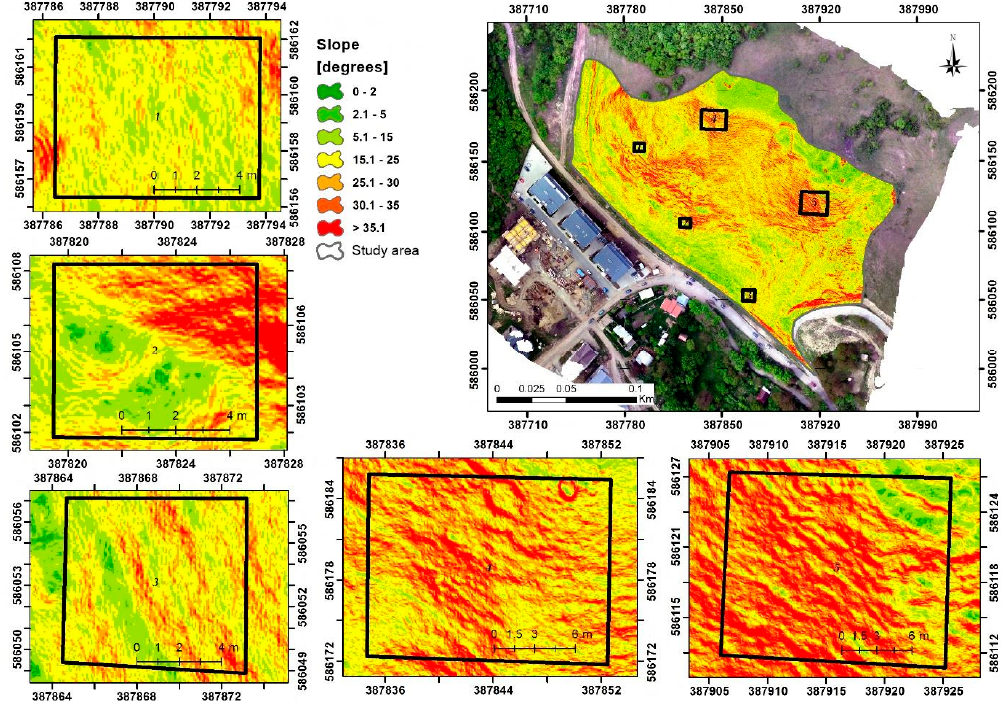
Figure 16. Slope of the study area with the five plots highlighted. The direction of water flow on the terrain is an important factor for the analyzed process, which must be taken into account especially when analyzing the general direction of displacement. As in the case of the slope, the analysis of the direction of water flow was analyzed in relation to the entire study area and based on the five plots previously identified (Figure 17).